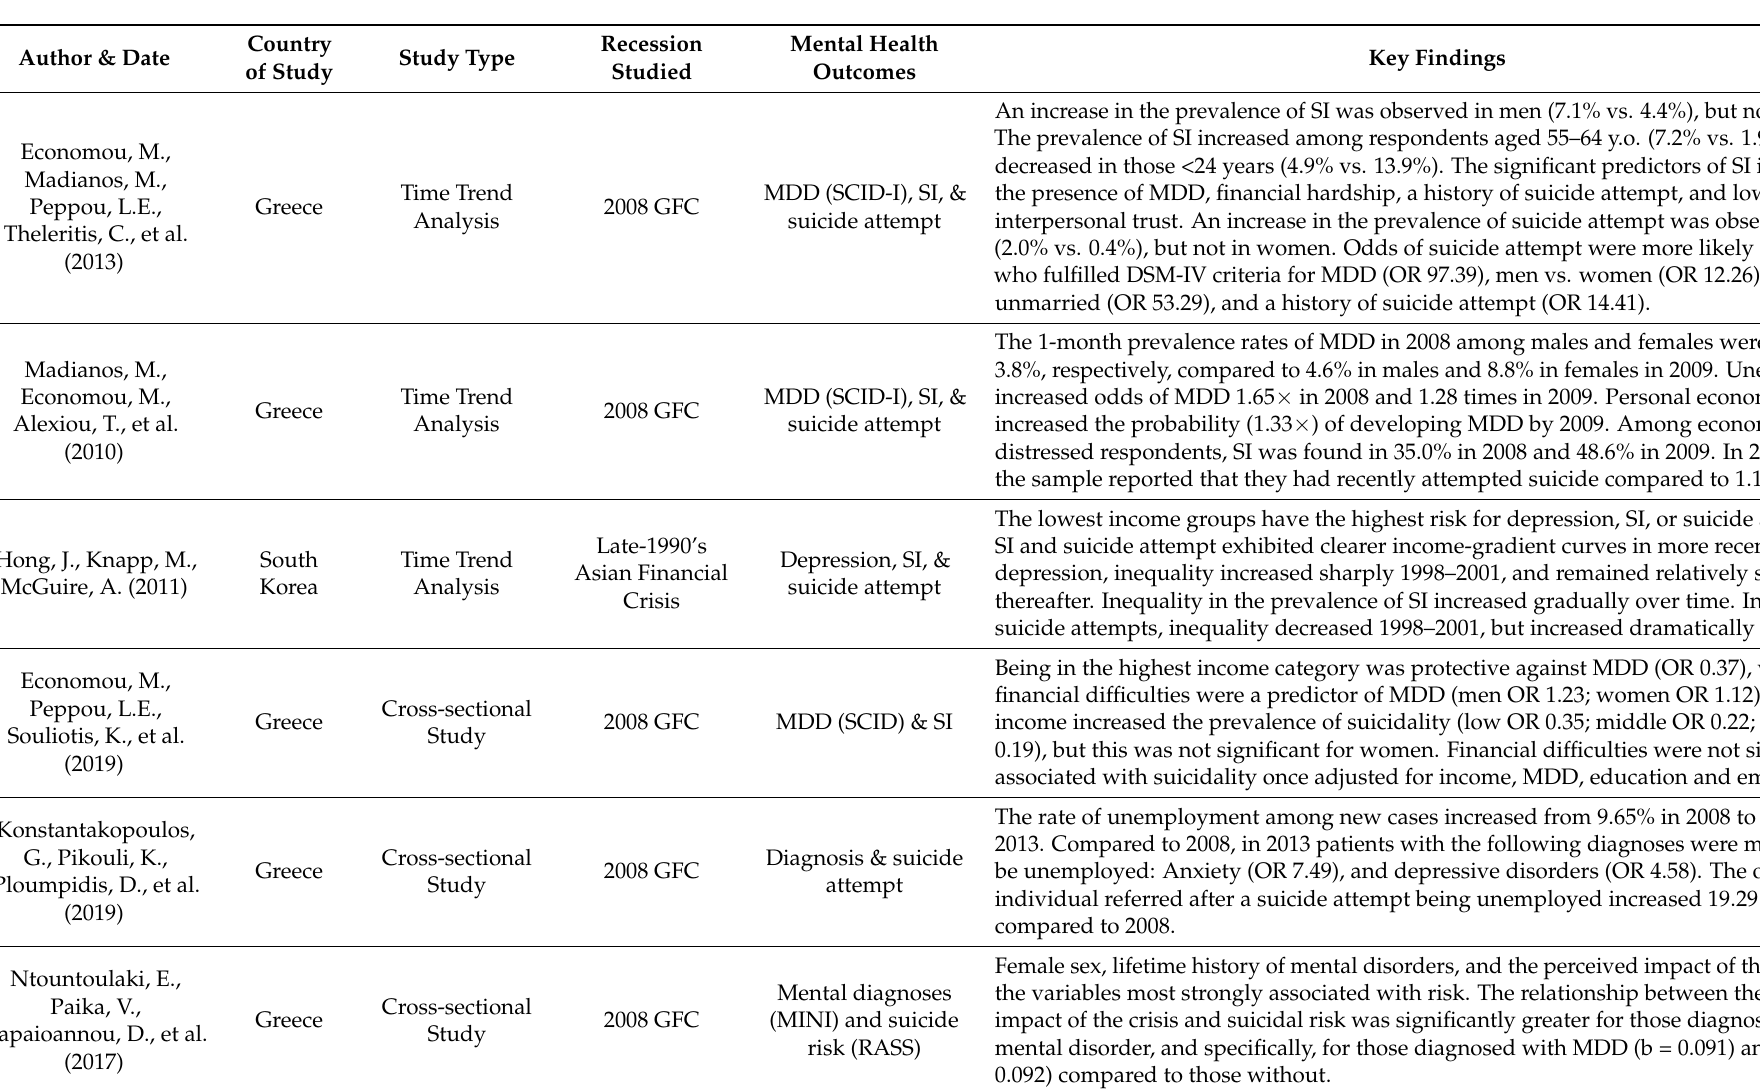
An increase in the prevalence of SI was observed in men (7.1% vs. 4.4%), but not in women. The prevalence of SI increased among respondents aged 55–64 y.o. (7.2% vs. 1.9%), while it decreased in those <24 years (4.9% vs. 13.9%). The significant predictors of SI in 2011 were the presence of MDD, financial hardship, a history of suicide attempt, and low interpersonal trust. An increase in the prevalence of suicide attempt was observed in men (2.0% vs. 0.4%), but not in women. Odds of suicide attempt were more likely for people who fulfilled DSM-IV criteria for MDD (OR 97.39), men vs. women (OR 12.26), married vs. unmarried (OR 53.29), and a history of suicide attempt (OR 14.41). The 1-month prevalence rates of MDD in 2008 among males and females were 2.4% and 3.8%, respectively, compared to 4.6% in males and 8.8% in females in 2009. Unemployment increased odds of MDD 1.65 × in 2008 and 1.28 times in 2009. Personal economic distress increased the probability (1.33 × ) of developing MDD by 2009. Among economically distressed respondents, SI was found in 35.0% in 2008 and 48.6% in 2009. In 2008, 0.6% of the sample reported that they had recently attempted suicide compared to 1.1% in 2009. The lowest income groups have the highest risk for depression, SI, or suicide attempt and SI and suicide attempt exhibited clearer income-gradient curves in more recent years. For depression, inequality increased sharply 1998–2001, and remained relatively stable thereafter. Inequality in the prevalence of SI increased gradually over time. In the case of suicide attempts, inequality decreased 1998–2001, but increased dramatically 2005–2007. Being in the highest income category was protective against MDD (OR 0.37), while financial difficulties were a predictor of MDD (men OR 1.23; women OR 1.12). For men MDD (SCID) & SI income increased the prevalence of suicidality (low OR 0.35; middle OR 0.22; high OR 0.19), but this was not significant for women. Financial difficulties were not significantly associated with suicidality once adjusted for income, MDD, education and employment. The rate of unemployment among new cases increased from 9.65% in 2008 to 26.17% in 2013. Compared to 2008, in 2013 patients with the following diagnoses were more likely to be unemployed: Anxiety (OR 7.49), and depressive disorders (OR 4.58). The odds of an attempt individual referred after a suicide attempt being unemployed increased 19.29 × in 2011 compared to 2008. Female sex, lifetime history of mental disorders, and the perceived impact of the crisis were the variables most strongly associated with risk. The relationship between the perceived impact of the crisis and suicidal risk was significantly greater for those diagnosed with any mental disorder, and specifically, for those diagnosed with MDD (b = 0.091) and GAD (b = 0.092) compared to those